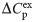
Enzymatic activity and heat stability of UV-Phb.(A) Dependence of the relative enzymatic activity A/A0. (B) Dependences of the excess heat capacity (ΔCpex) on temperature for intact Phb and Phb irradiated by different UV doses. The initial concentration of Phb was 1.5 mg/ml. ΔCpex was calculated per Phb dimer (Mr = 194800 Da). (C) Position of the maximum Tmax on the DSC profiles. (D) Relative denaturation heat Q/Q0. Conditions of the experiments: 0.03 M Hepes buffer, pH 6.8, containing 0.1 M NaCl. A0 and A are the values of enzymatic activity for intact Phb and UV-Phb, respectively. Q0 and Q are the values of the area under DSC profile for intact Phb and UV-Phb, respectively. Three independent measurements were used to determine the arrow bars shown in this figure.